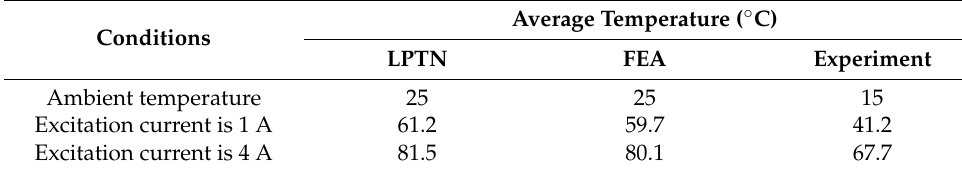
Figure 19. Schematic diagram of temperature when the excitation current is 4 A. Table 4. Comparison of LPTN, FEA results, and experimental results.